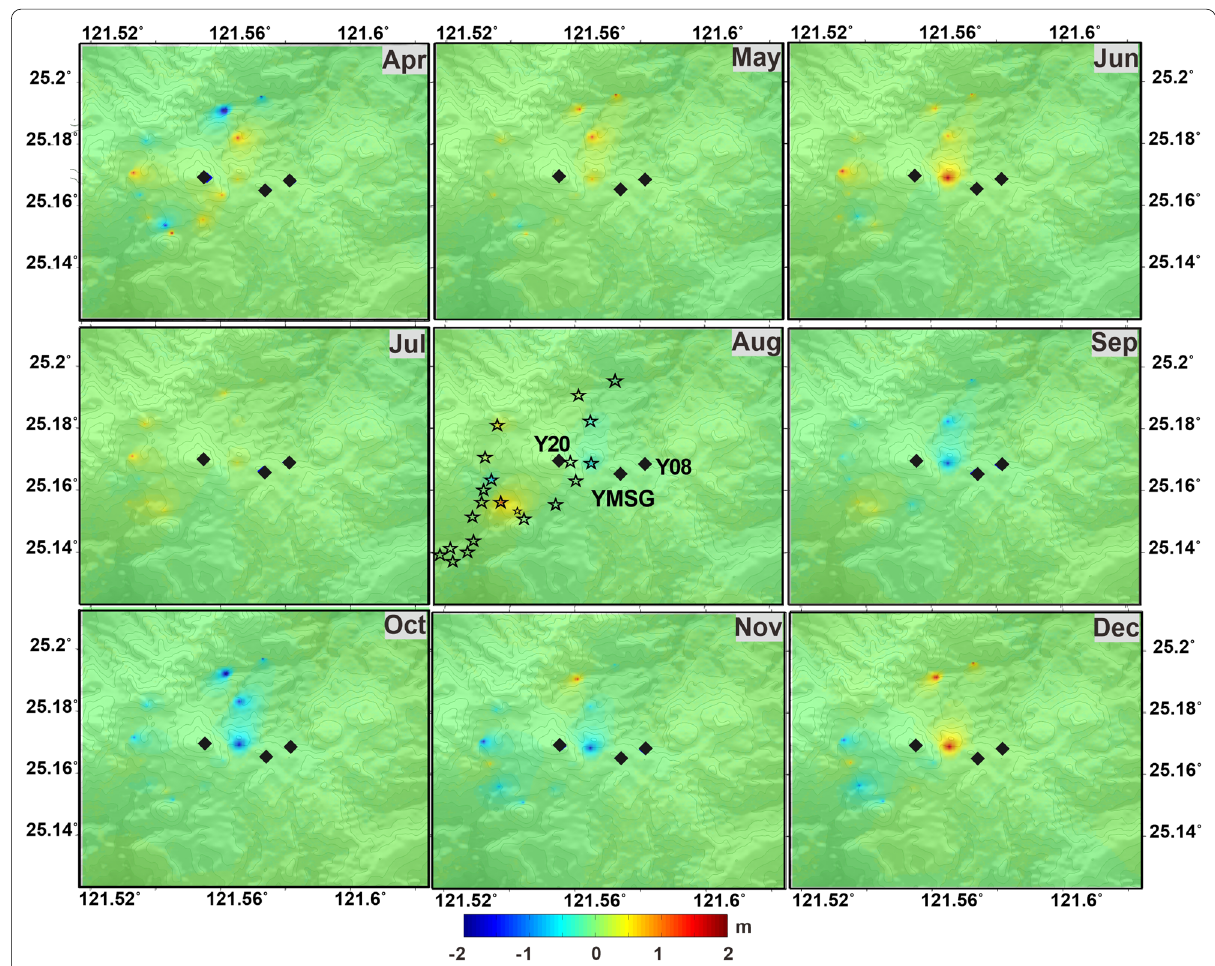
Fig. 5 Groundwater level variations of Model A. The variations are relative to the mean levels of modeled values over April–December 2012. The locations of the groundwater wells are indicated by open stars in the August